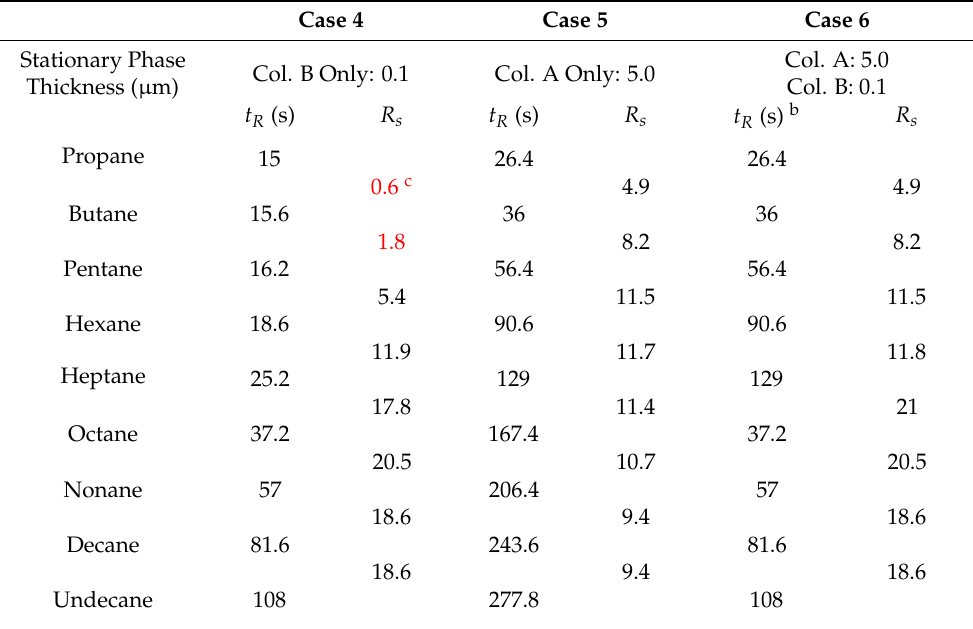
Table 3. Computed a values of retention time of various alkanes and separation resolution between pairs of alkanes for temperature programmed Cases 4–6. Case 4 Case 5 Case